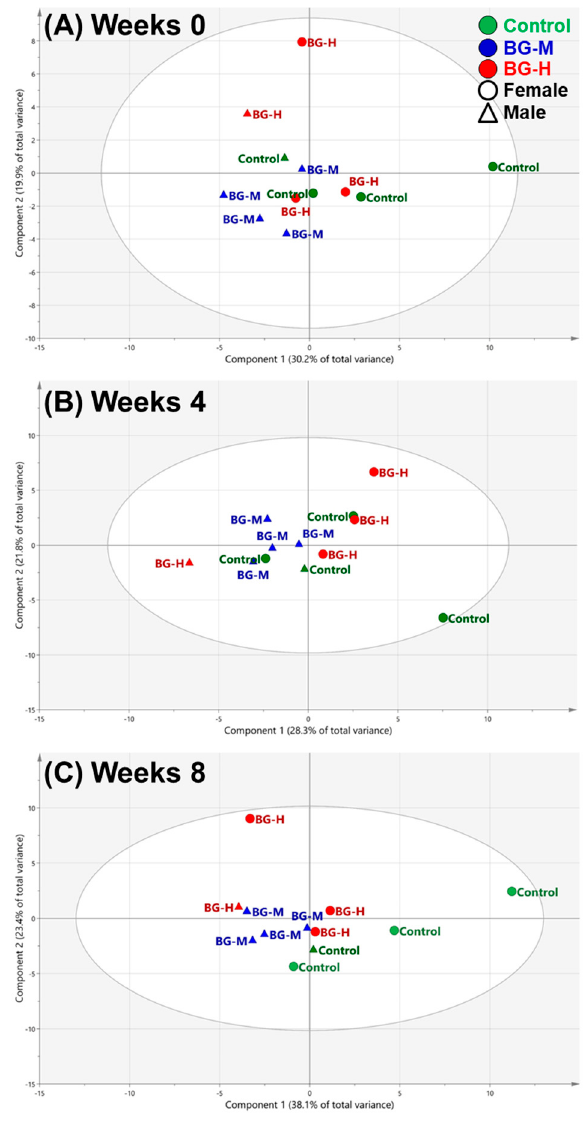
Figure 2. Score plots of the principal component analyses (PCA) models obtained from 49 metabolites in the serum of beagle dogs fed on a control, medium concentration of BG extract (BG-M), or BG-H diet at 0 ( A ), 4 ( B ), and 8 ( C ) weeks. Control, a regular diet; BG-M, regular diet with a medium concentration of BG extract; BG-H, regular diet with a high concentration of BG